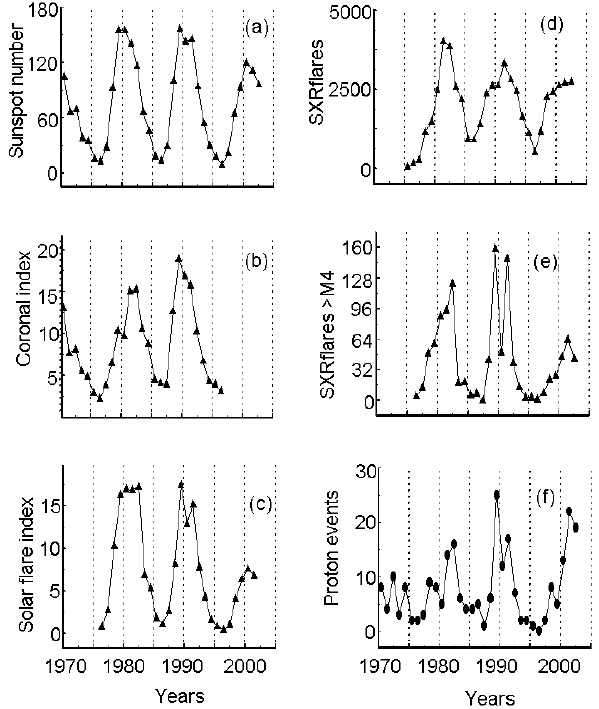
Fig. 2. Time distributions of the yearly values of ( a ) sunspot num- ber, ( b ) coronal index, ( c ) solar flare index, ( d ) SXR flares num- ber, ( e ) SXR flares number with importance > M4 and ( f ) proton event number with E > 10MeV and peak intensity > 10pfu, during the time interval 1970–2002.